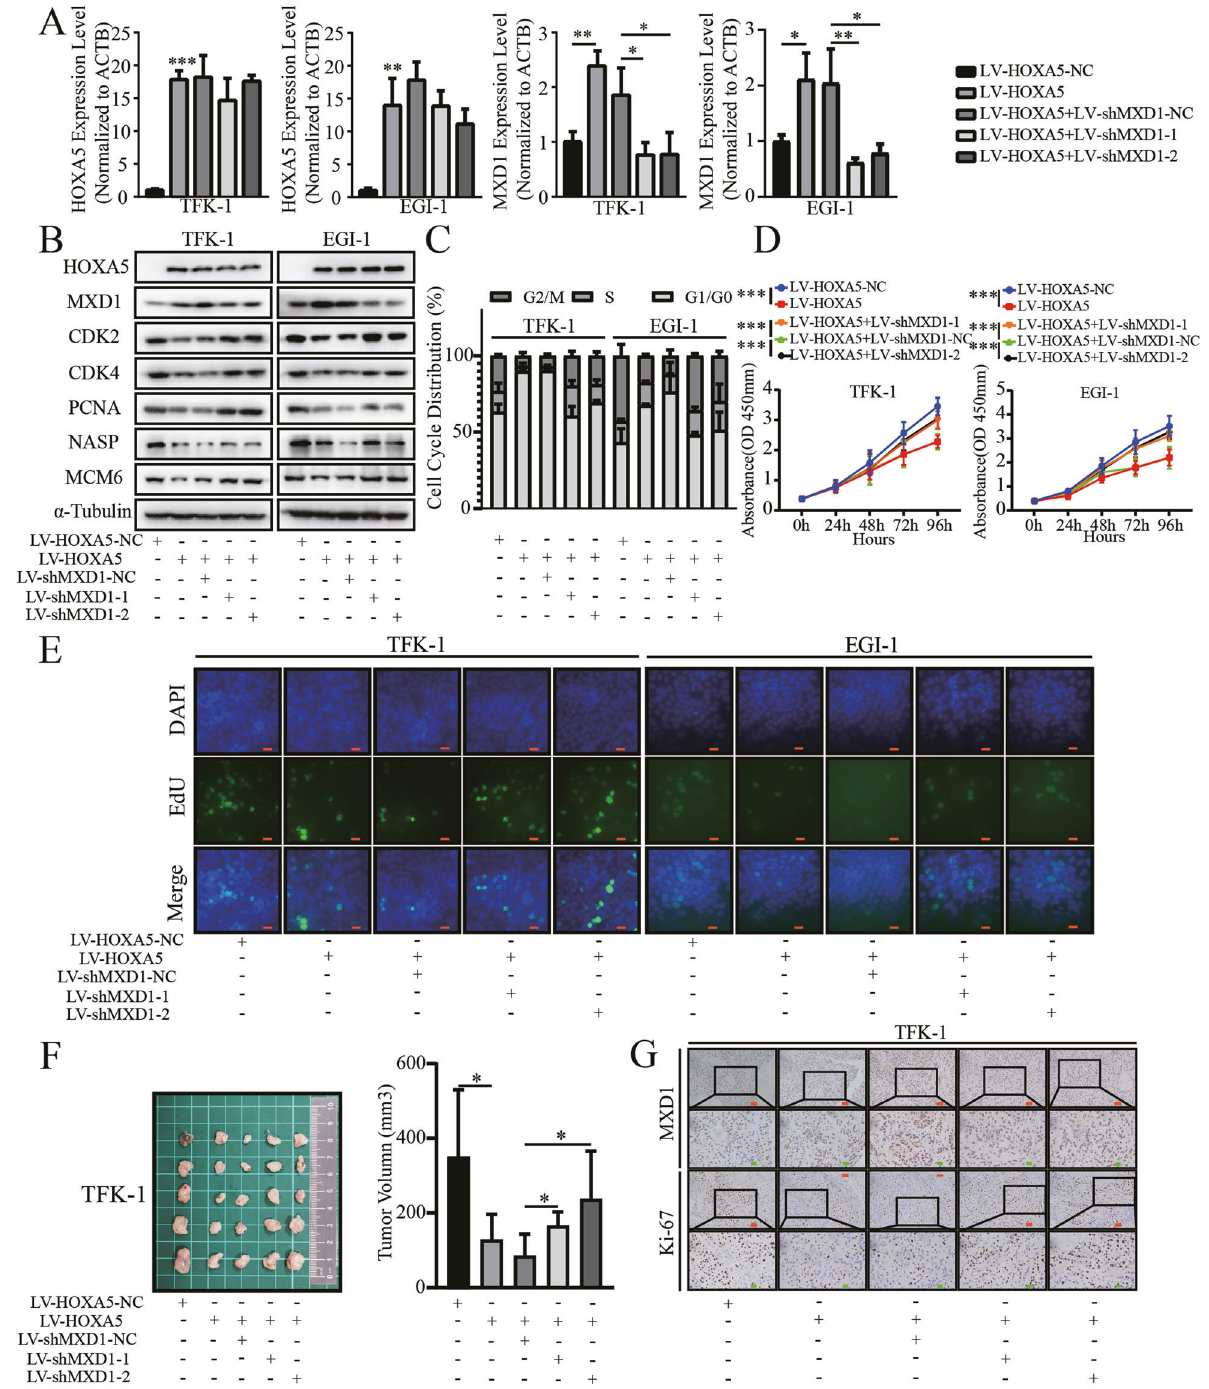
Fig. 6 MXD1 silencing mitigates the inhibition of HOXA5 overexpression on the proliferation of ECCA cells. A , B MXD1 silencing did reduce MXD1, but not HOXA5 expression, and partially rescued the expression of mitosis-related genes in ECCA cells. C – E MXD1 silencing abrogated the inhibition of HOXA5 overexpression on the cell cycle and proliferation of ECCA cells. F MXD1 silencing partially rescued the tumor volumes in the HOXA5 over-expressing ECCA tumors from nude mice. G Immunohistochemistry analysis of MXD1 and Ki67 expression in xenograft tumors from nude mice. * P < 0.05. ** P < 0.01. *** P < 0.001. Orange bar, 50 μ m. Green bar, 20 μ m. cell-cycle promoting factors (CCNE1, CCNB1 and GTSE1) were promoting factors, such as Cyclins and CDKs, were down- down-regulated in the HOXA5 overexpressed cell, which were regulated while the cell cycling inhibitors, GADD45A and rescued by MXD1 silencing (Fig. 7D). In contrast, pro-apoptotic GADD45G, were up-regulated. Among the apoptosis-associated factors were up-regulated in the HOXA5 over-expressed cells, genes, some pro-apoptotic factors, such as BID, were not up- except for BID. However, their gene transcripts were not regulated, though HOXA5 overexpression could enhance sponta- signi fi cantly altered by MXD1 silencing, consistent with the neous apoptosis (Fig. S4B). Further RT-qPCR revealed that three